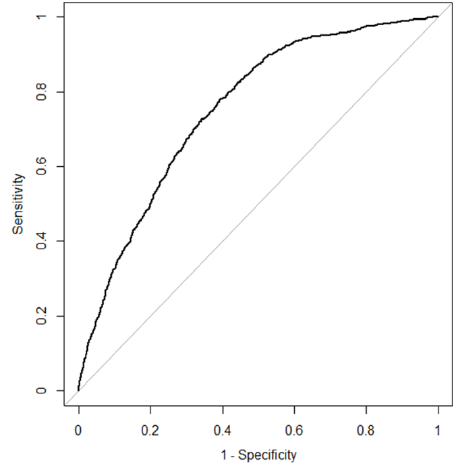
Figure 5. ROC curve for neural network (NN) (Tanh). (AUC = 0.768, F-score = 0.741).